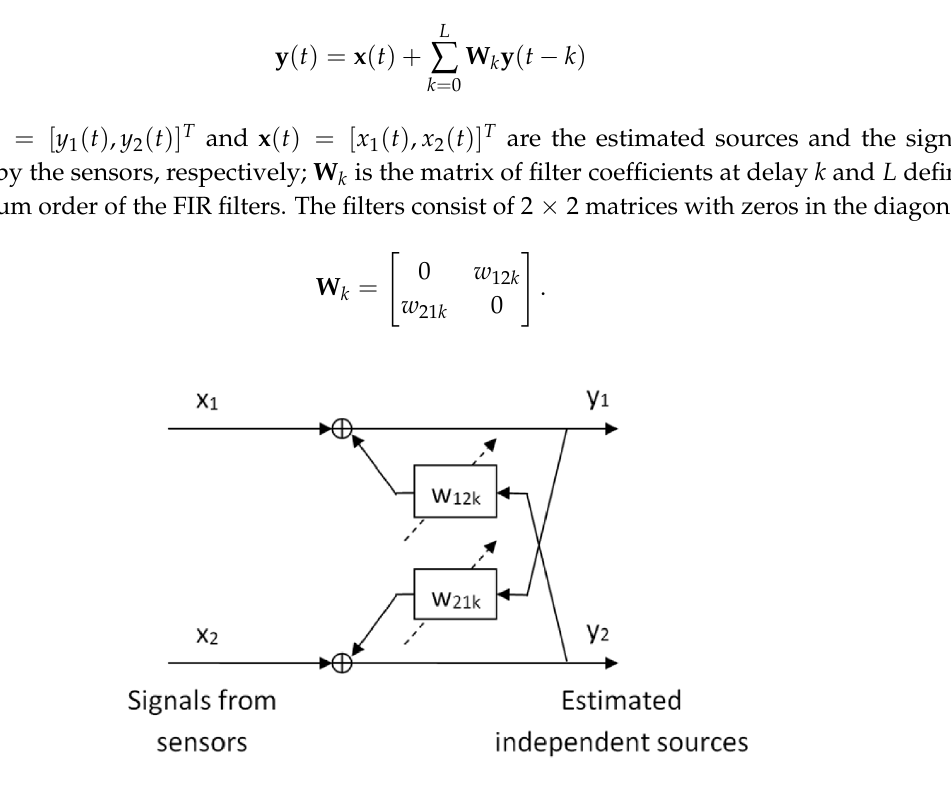
Figure 3. Schematic representation of the independent component analysis (ICA) algorithm. W 12 k and W 21 k are two recurrent filters whose coefficients are determined using an unsupervised learning